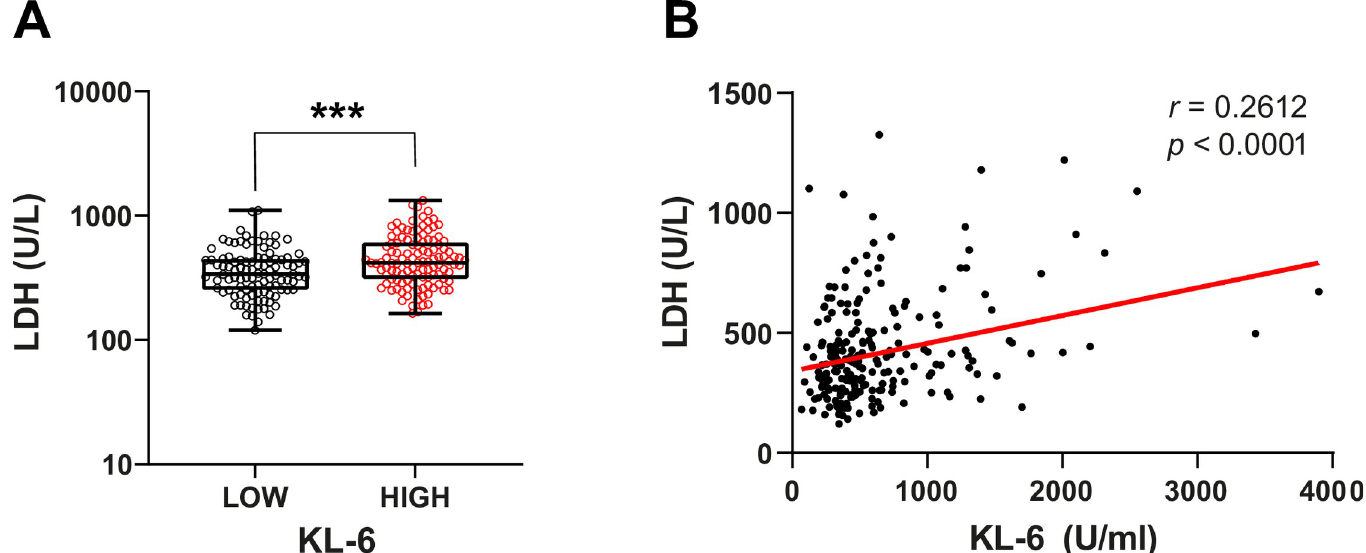
Fig 3. Correlation between KL-6 and LDH levels in COVID-19 patients. ( A ) Comparison of LDH levels between COVID-19 patients with high and low KL-6 levels. High KL-6 patients display a significantly higher LDH level. Data are analyzed using a non-parametric two-tailed Mann-Whitney test. ��� P < 0.001. ( B ) Correlation between KL-6 and LDH levels. Data are analyzed using Spearman correlation.